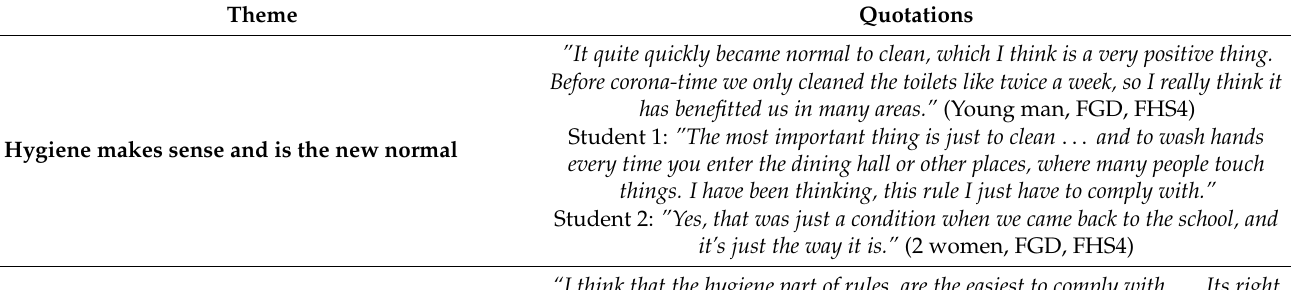
Table 4. Students’ views on hygiene